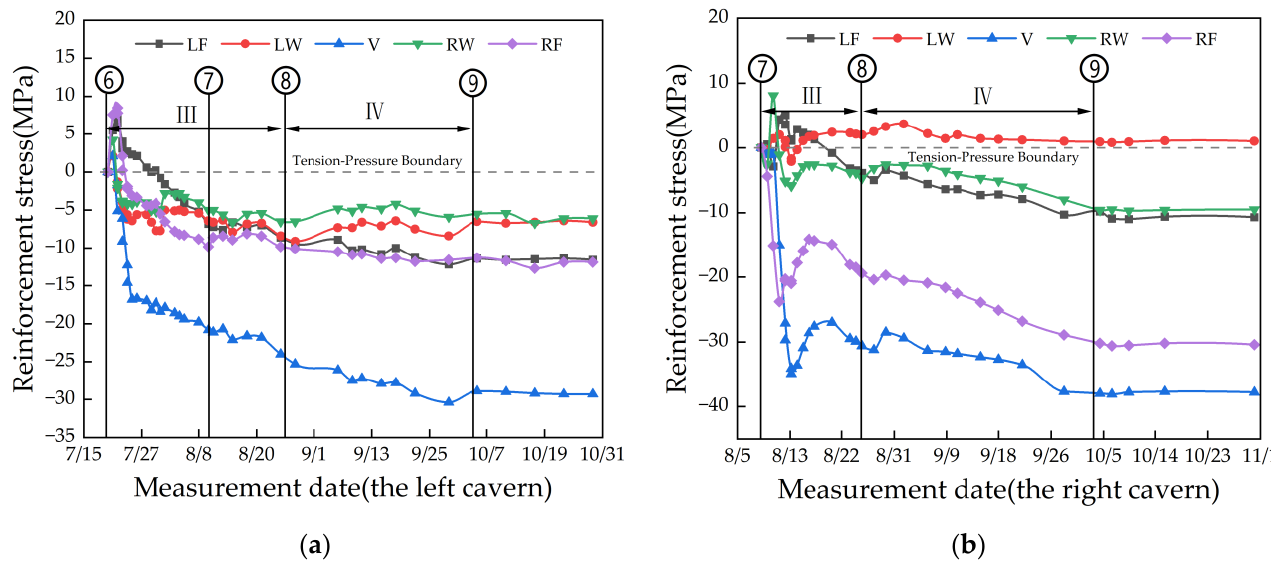
Figure 9. Steel stress of the secondary lining versus time. ( a ) Left cavern; ( b ) right cavern.